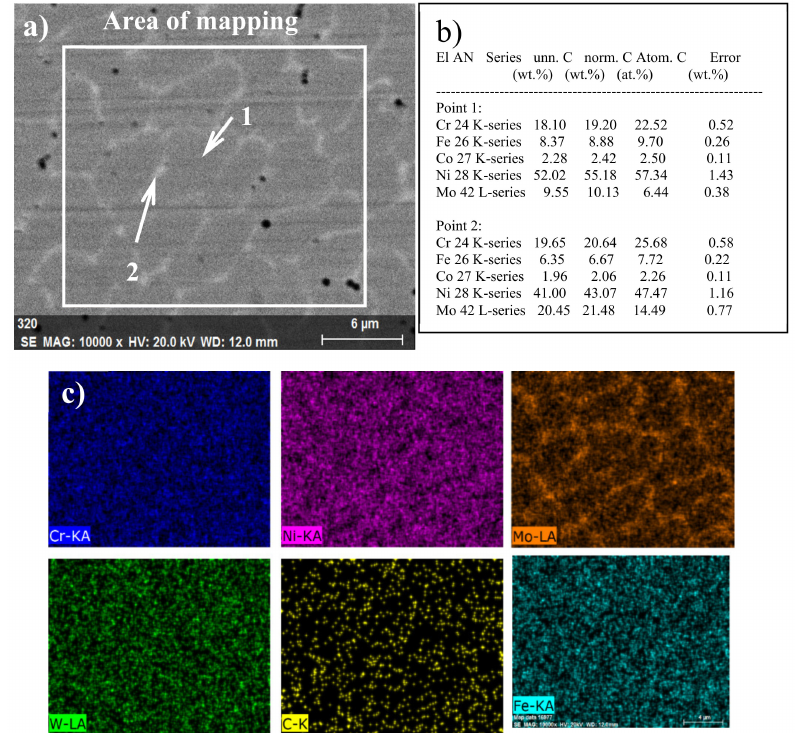
Figure 5. Elemental content of selected point and element mapping of the C22 coating by EDS. ( a ) Area of mapping in SEM; ( b ) Elemental content of selected points; ( c ) Elemental distribution.